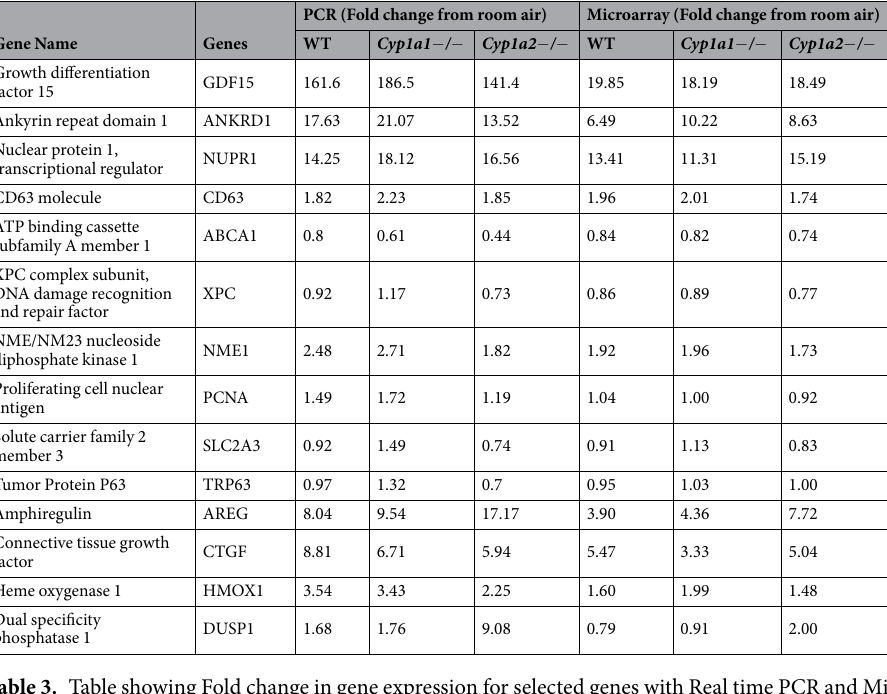
dinor metabolite from PGF2- α showing that F 2 -isoprostanes are endogenous substrates for CYP1A2 17 . In Cyp1a2 − / − mice, these compounds would accumulate, be transported to the systemic circulation, and lead to increased lung injury. Using a similar methodology, we also showed that CYP1A1 has a protective role in part due to CYP1A1-mediated decrease in the levels of reactive oxygen species-mediated lipid hydrop- eroxides e . g . F 2 -isoprostanes/isofurans, leading to attenuation of oxidative damage 16 . Compounds such as omeprazole, a proton pump inhibitor and beta-naphtoflavone, a flavonoid have been shown to attenuate hyperoxic lung injury by inducing CYP1A 12, 13, 35 . We reported differential gene expression in the lungs after hyperoxia exposure for 48 hours and identified genes that are differentially expressed unique to each of the genotypes as well as those that are common. We analyzed differences in gene expression at the 48 h time point because most animals displayed severe lung injury by 72 h, and many died between 60–90 h of exposure 34 . We focused on pathways that were regulated in opposite